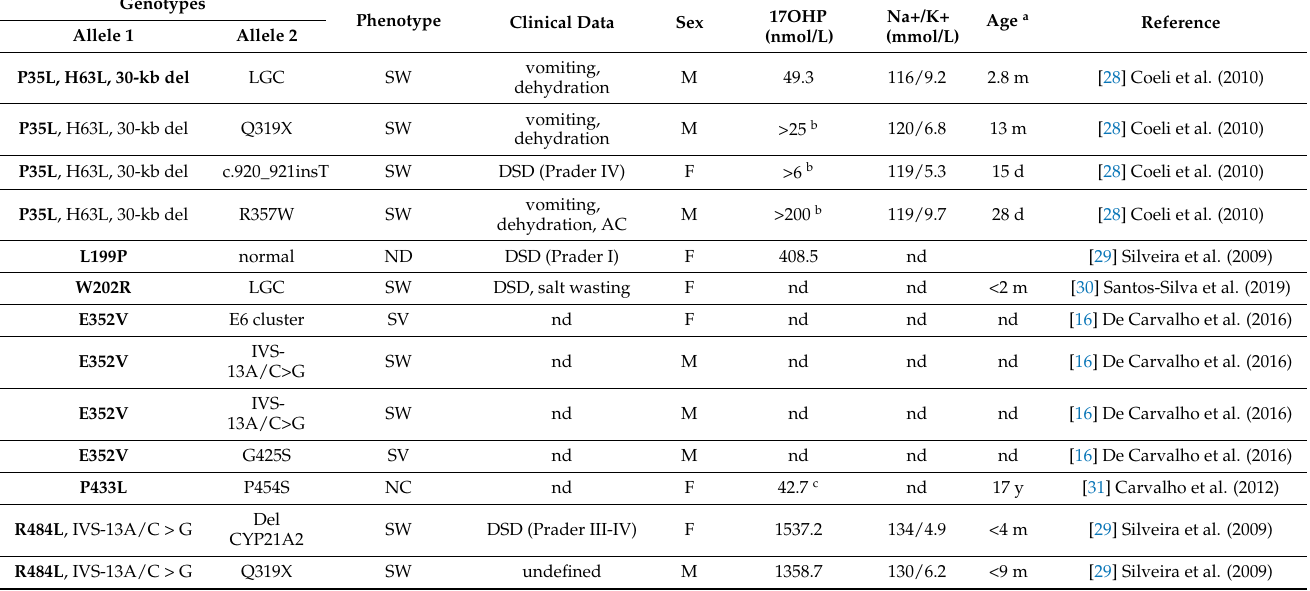
Table 1. Genetic and clinical features of the subjects carrying the selected SNVs (bold) in the CYP21A2 gene. All data are from the original papers. Normal values for 17 α -hydroxyprogesterone (17OHP) are <30 nmol/L, serum sodium between 132–142 mmol/L and potassium 3.6–6.1 mmol/L. LGC, large gene conversion; 30-kb del, large deletion from CYP21A1P to CYP21A2 gene; nd, non-determined; DSD, ambiguous/atypical genitalia; AC, adrenal crisis; M, male; F, female. a Age at